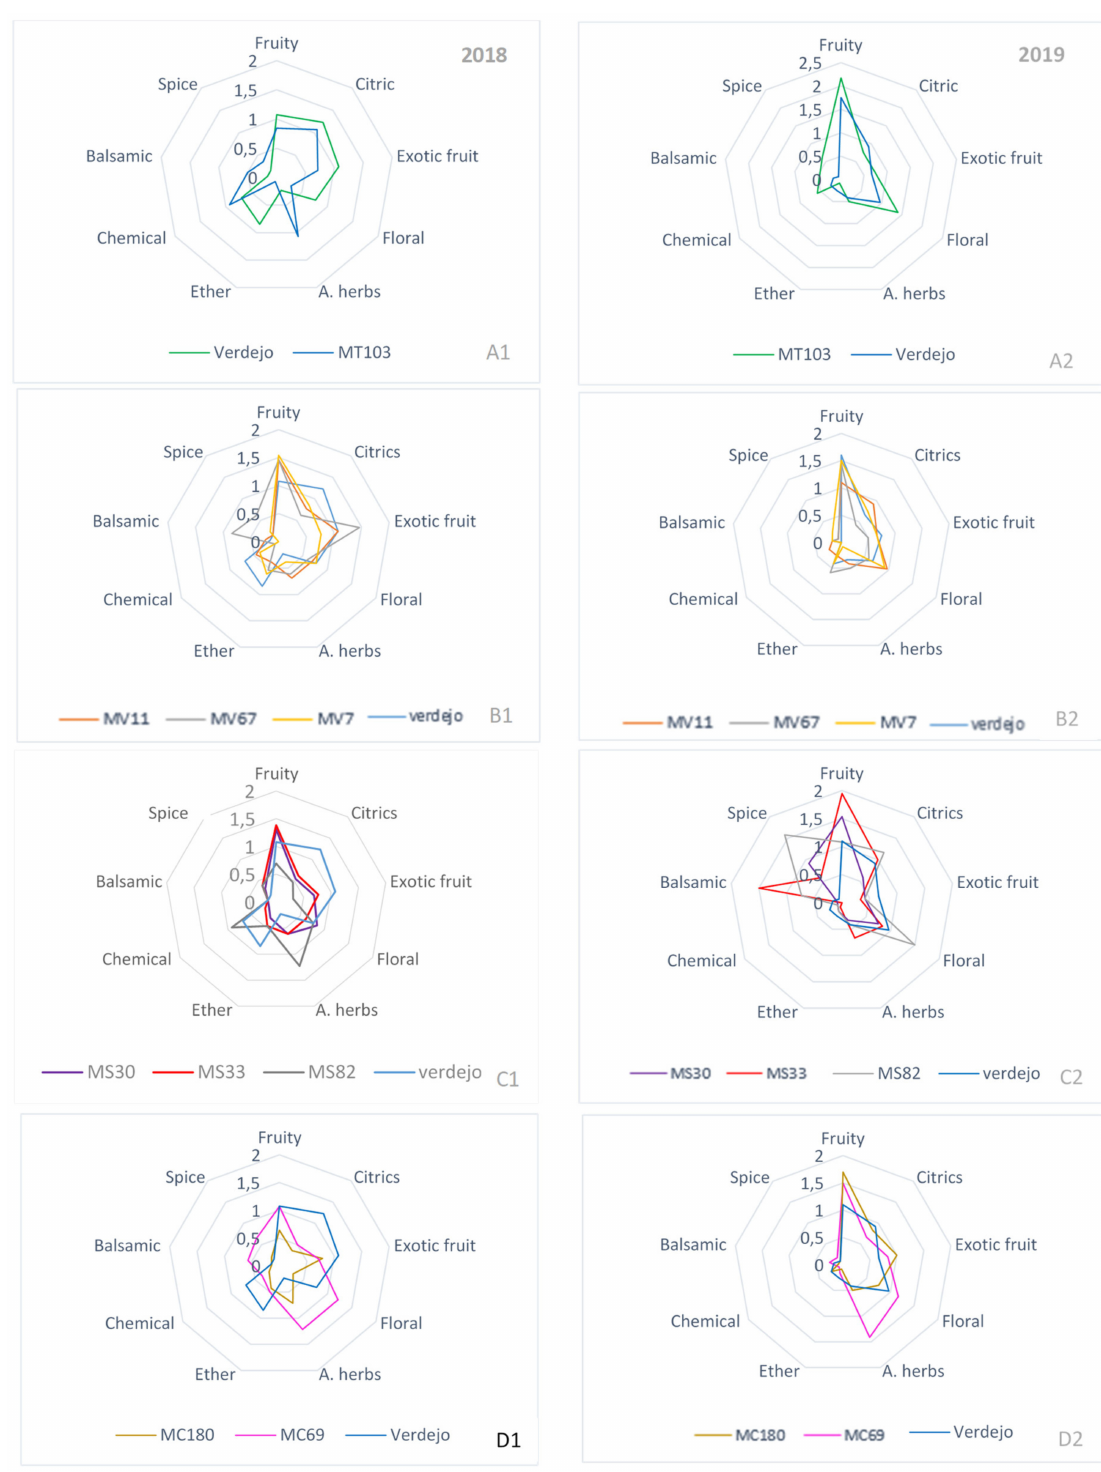
Figure 2. Sensory analysis of 2018 ( A1 – D1 ) and 2019 wines ( A2 – D2 ). ( A ) shows Tempranillo cross with Monastrell. ( B ) encompasses the Verdejo family. ( C ) shows the di ff erent crosses of Monastrell x Syrah. ( D ) indicates the crosses of Monastrell x Cabernet Sauvignon. The aroma characteristics have relative standard deviation of below 0.05 (RSD <